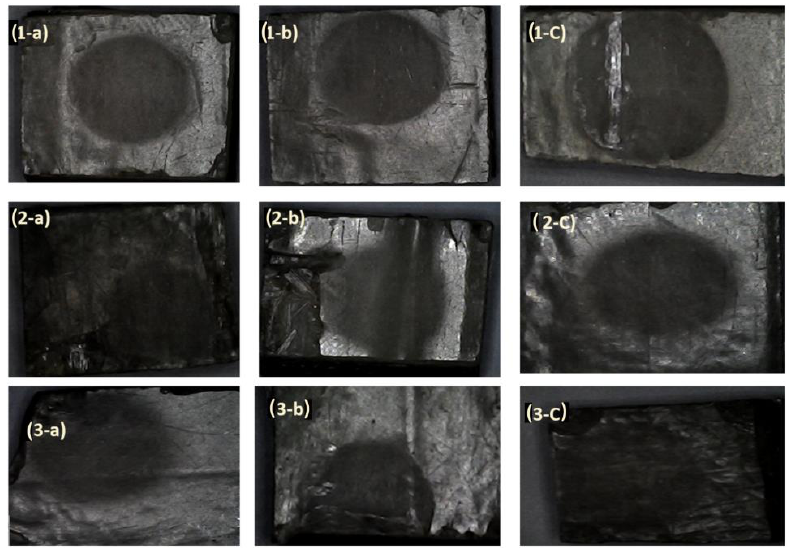
Figure 8. Failure mode at 2 h for ( a ) 250 g, ( b ) 400 g and ( c ) 500 g of sand at ( 1 ) 0.01 m 3 /min, ( 2 ) 0.0067 m 3 /min and ( 3 ) 0.01 m 3 /min +10 wt.% Cl.